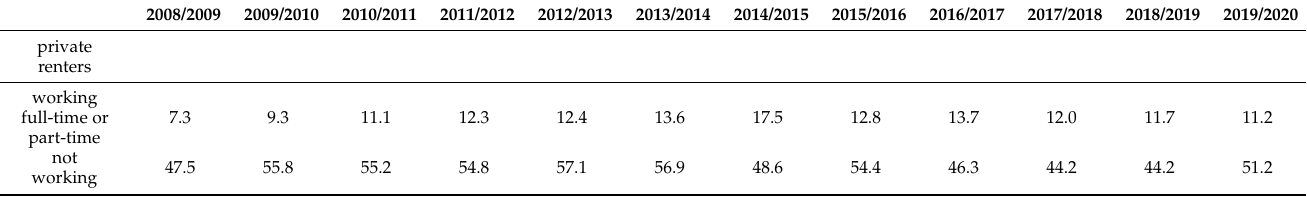
Table A13. Receipt of housing benefit, by economic status, 2008–2009 to 2019–2020